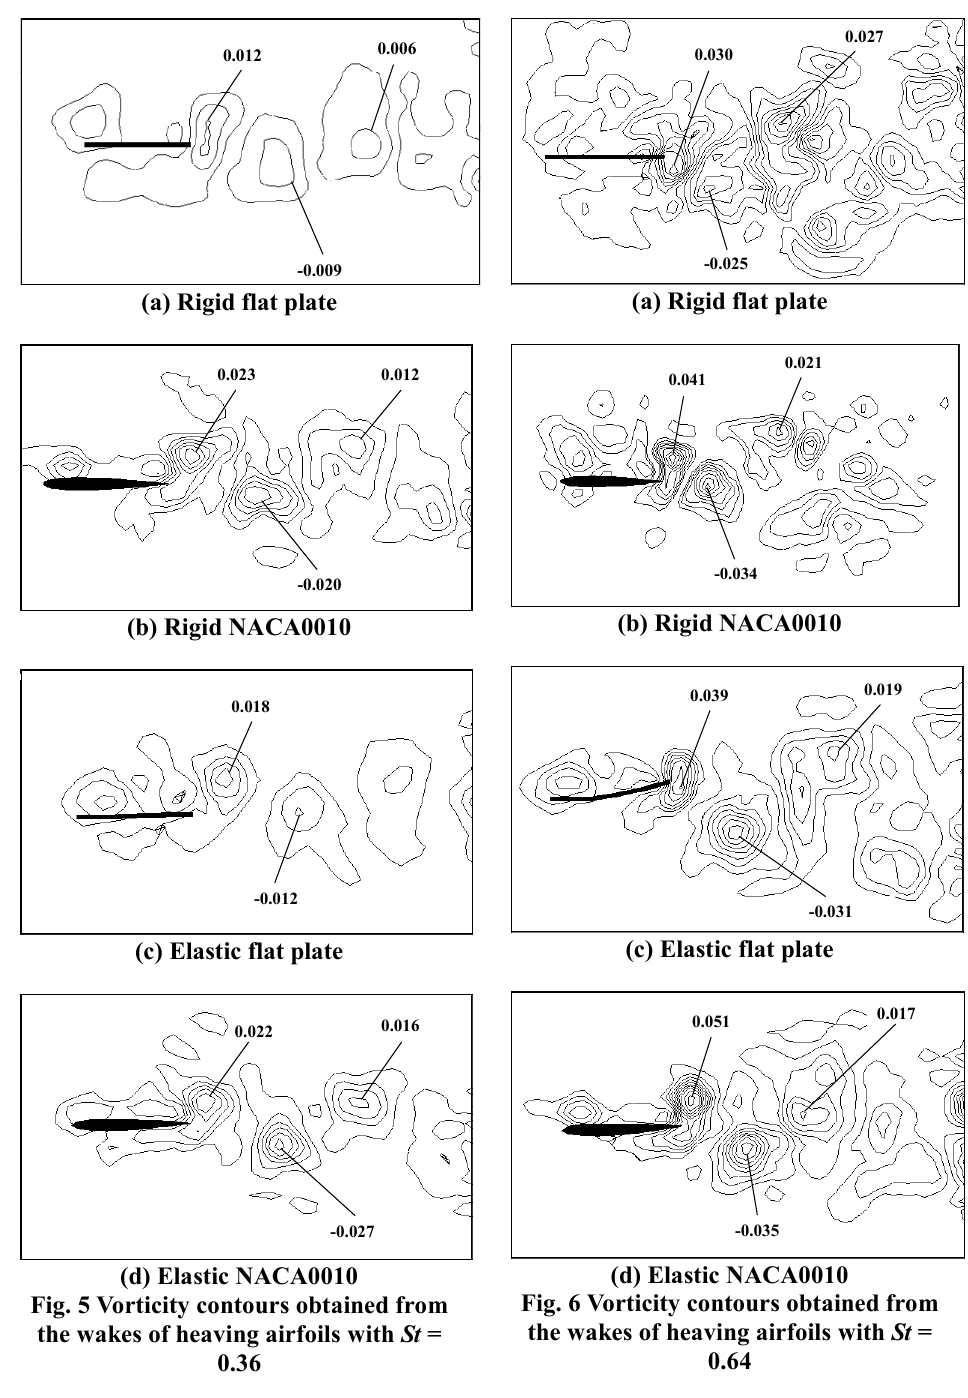
Fig. 5 Vorticity contours obtained from the wakes of heaving airfoils with St = 0.36